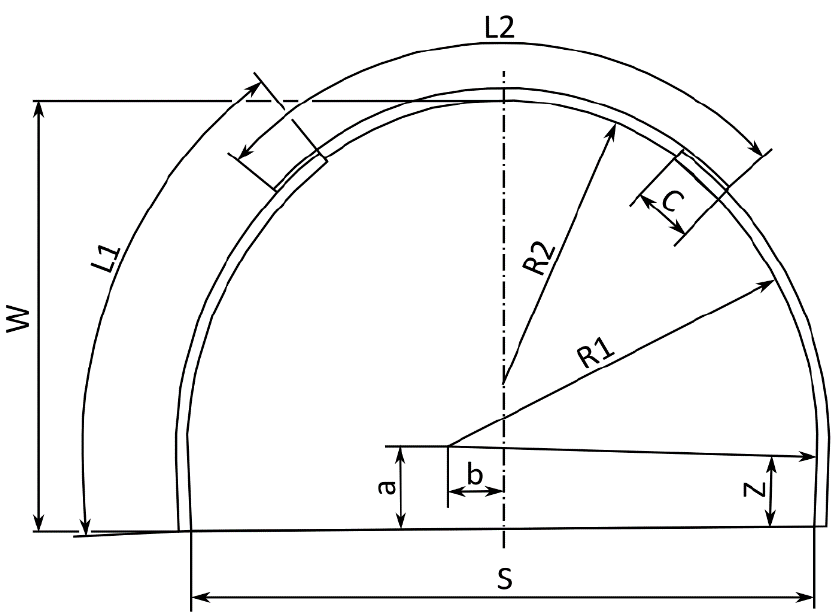
Figure 9. Dimensions of arch yielding support 8-KS/KO-21.